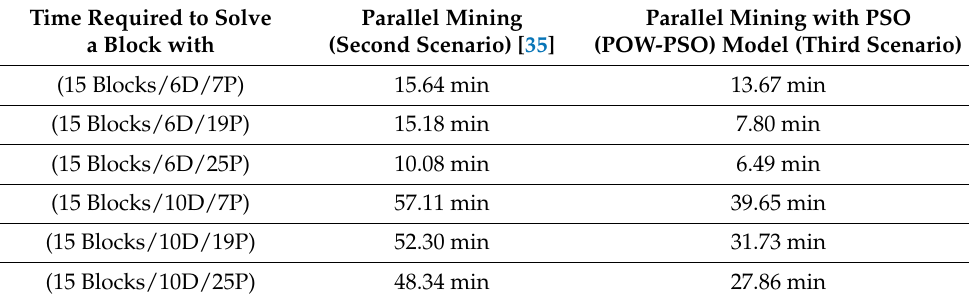
Table 4. Comparison between traditional parallel mining with proposed model (POW-PSO) against achieved